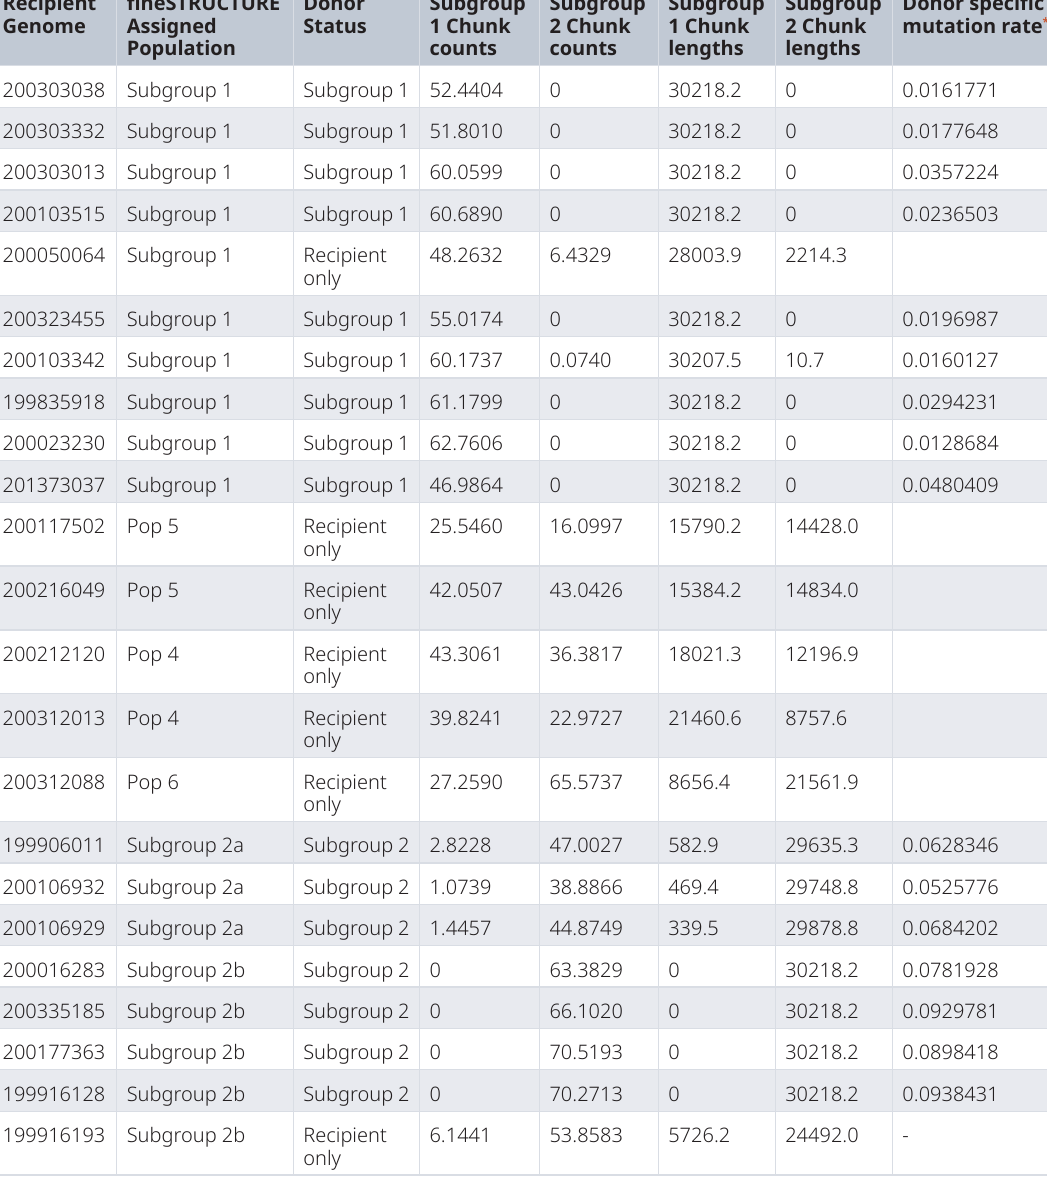
(Figure 2) and in terms of genetic distance (Table 3). The